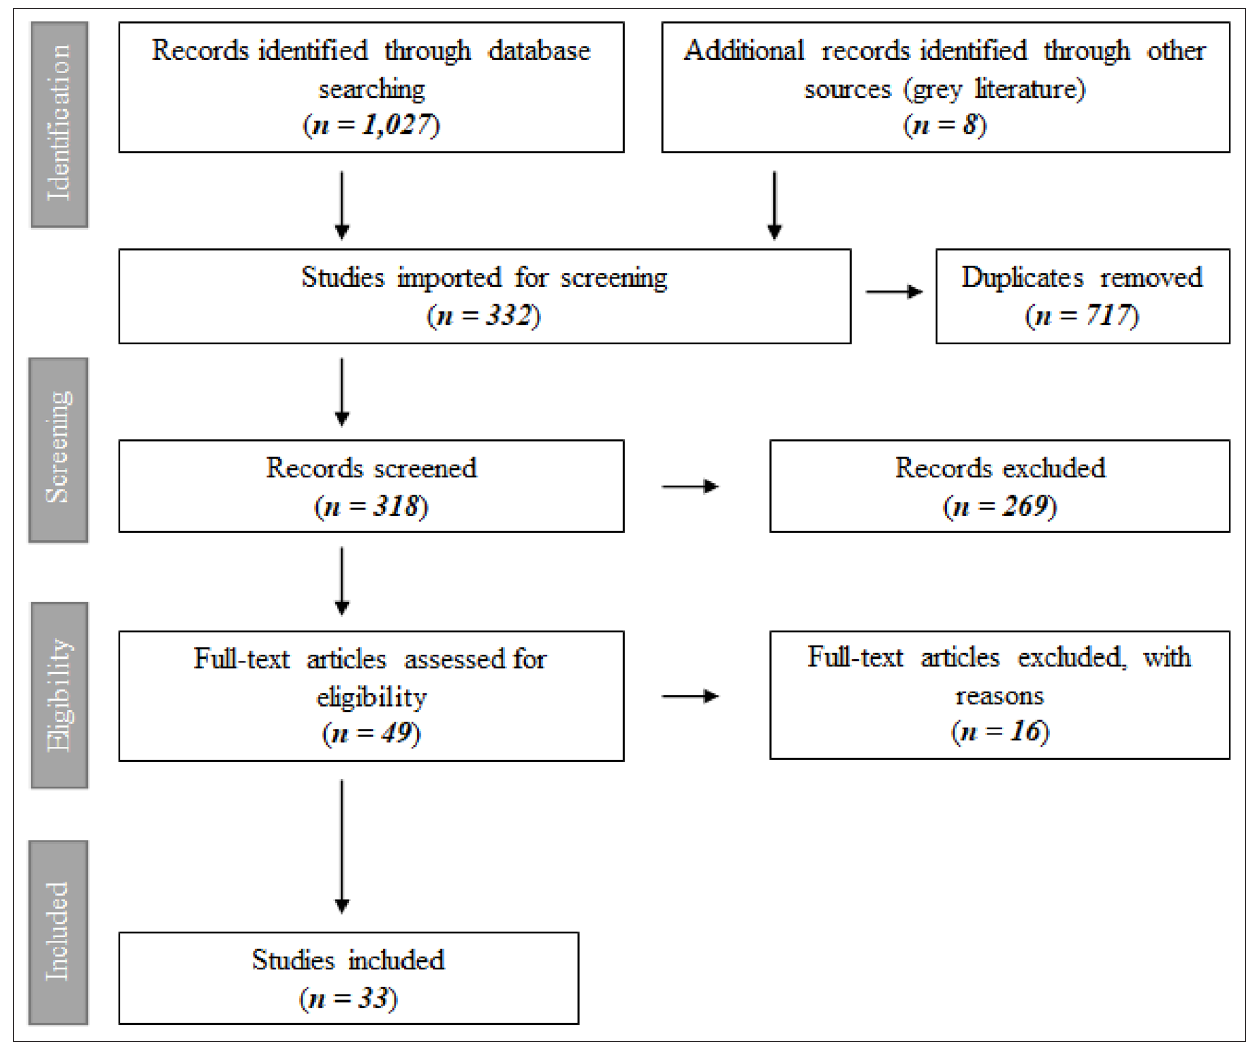
Figure 1 PRISMA extension for Scoping Reviews flow diagram showing the scoping review process for citizen science based mosquito surveillance